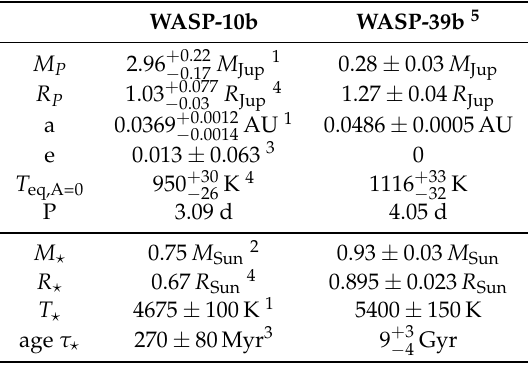
Table 1. Stellar and planetary